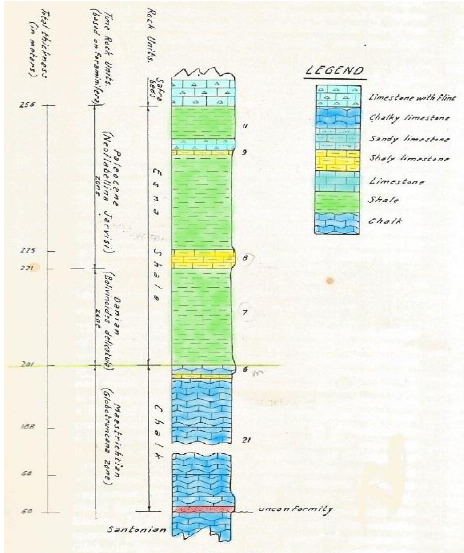
Figure 3: Columnar section showing the major subdivisions of the Nekhl section, northern Sinai, Egypt (after Said and Kenawy,